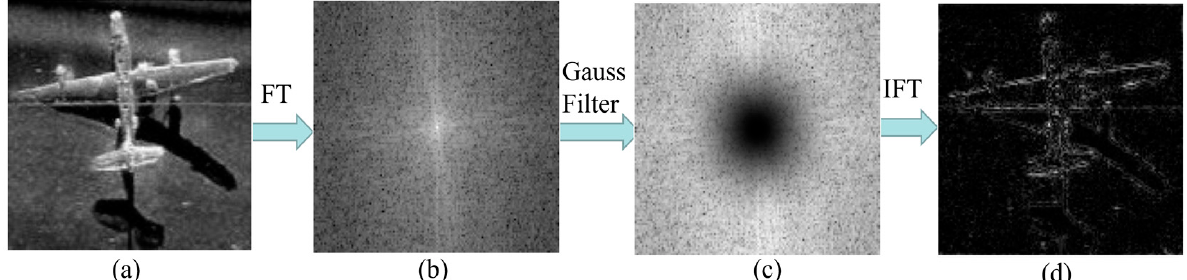
Figure 8. Frequency analysis on original sonar image. ( a ) Gray image on original sonar target. ( b ) Fourier transform on sonar image. ( c ) Gaussian filter frequency in frequency image. ( d ) Gaussian filtered image.